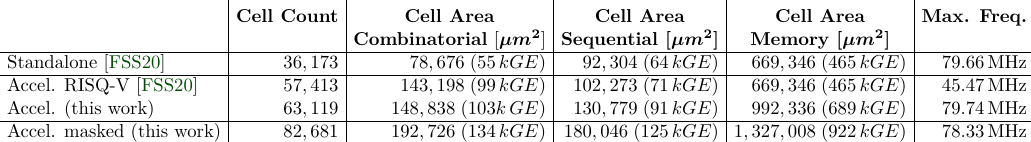
Table 6: Resource overview and estimated max. frequency ASIC synthesis (UMC 65 nm) Cell